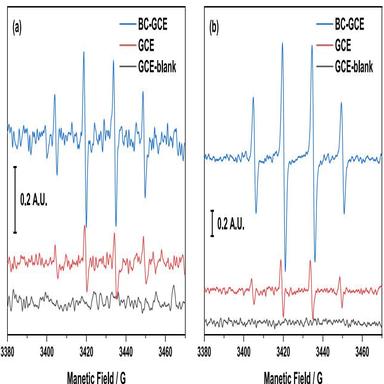
EPR spectra after electrolysis of 15 min (a) and 30 min (b) for different systems.